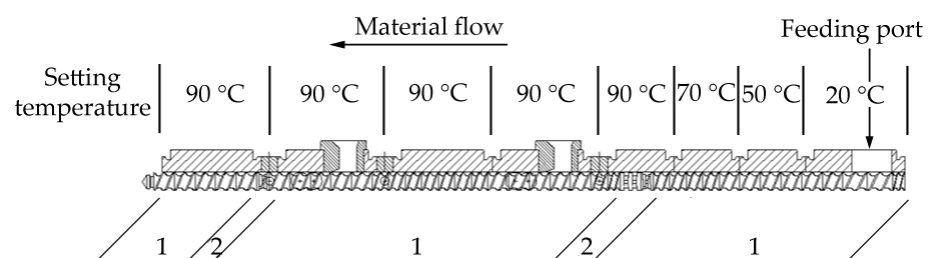
Figure 1. Used screw configuration and setting the temperature of heating blocks on the twin-screw- extruder (TSE) for the preparation of compounds (1. conveying elements, 2. kneading elements).